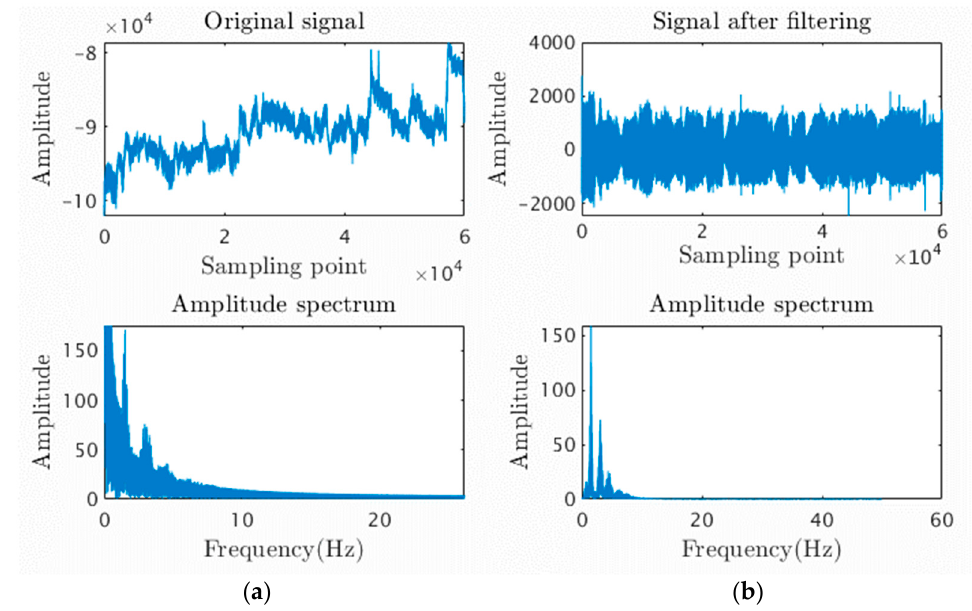
Figure 5. ( a ) Original signal and its spectrum; ( b ) Signal and spectrum after fi ltering.